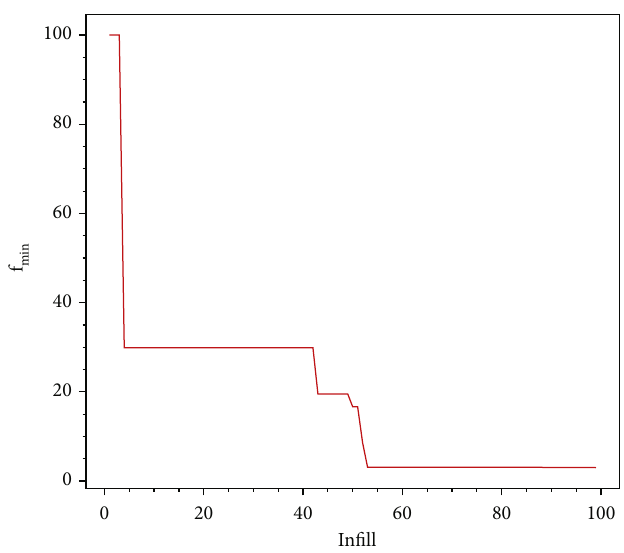
Figure 5: Convergence history of the objective function.